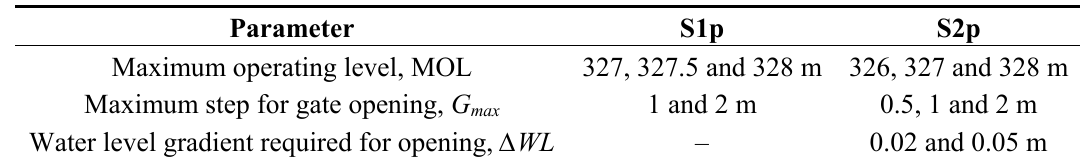
Table 2. Operating rule